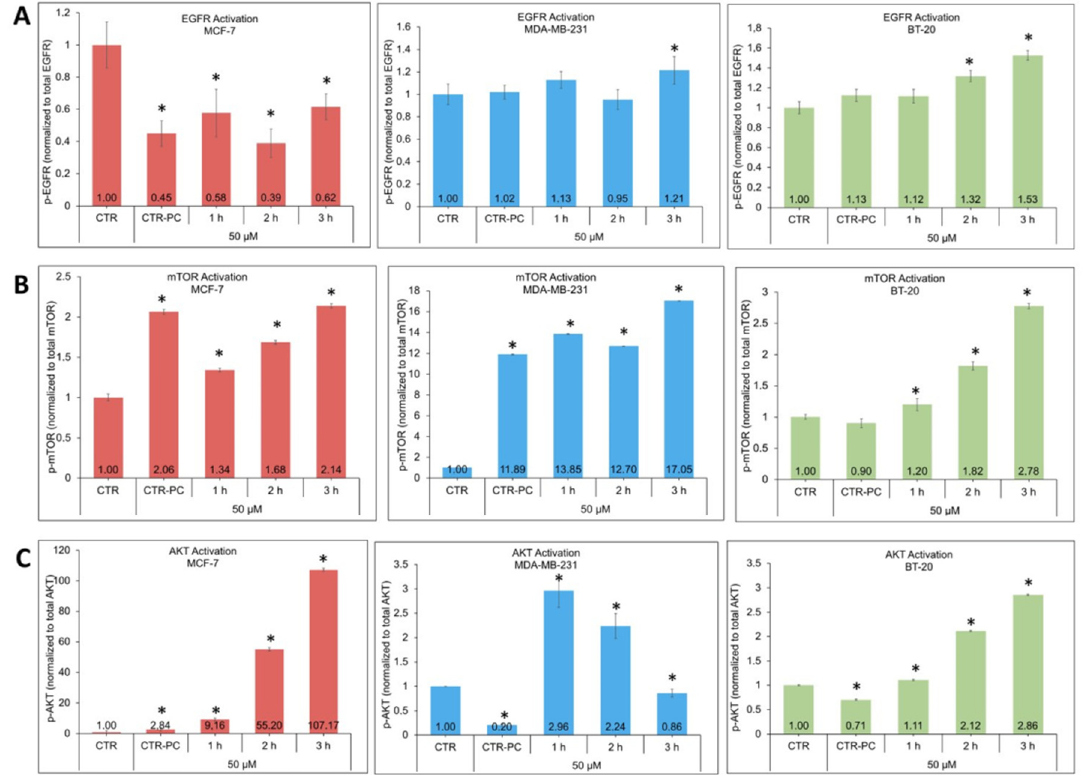
Figure 2. Calculation of the p-EGFR/EGFR ratio, ( A ) p-mTOR/mTOR and ( B ) p-AKT/AKT ( C ) for each experimental group (n = 6 in each experiment) treated with 50 µ M sapienic acid for the indicated time; CTR-PC = pulse and chase experiment (see Section 2). Values were mean ± SD. * Values significantly different from control ( p < 0.001). Western blot analyses are shown in Figures S3–S5 in Supplementary